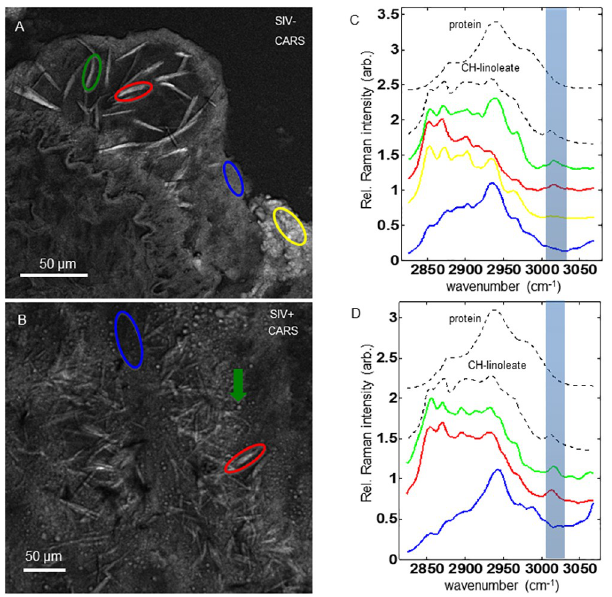
Fig 4. Hyperspectral scans of SIV + , and control, plaques detect a CE dominate signature. (A & C) spectral traces for two needle objects (green and red ovals), a protein rich area of the shoulder region (blue) and an amorphous lipid rich shoulder region (yellow) are shown for the control plaque. (B & D) SRS spectral traces for a needle object (red), a protein region (blue), and an amorphous lipid droplet (green arrow) of a SIV + plaque. The top two dashed black traces in C & D represent protein and cholesteryl-linoleate reference SRS spectra, respectively. Shaded spectral band indicates the spectral response of unsaturated acyl chains.